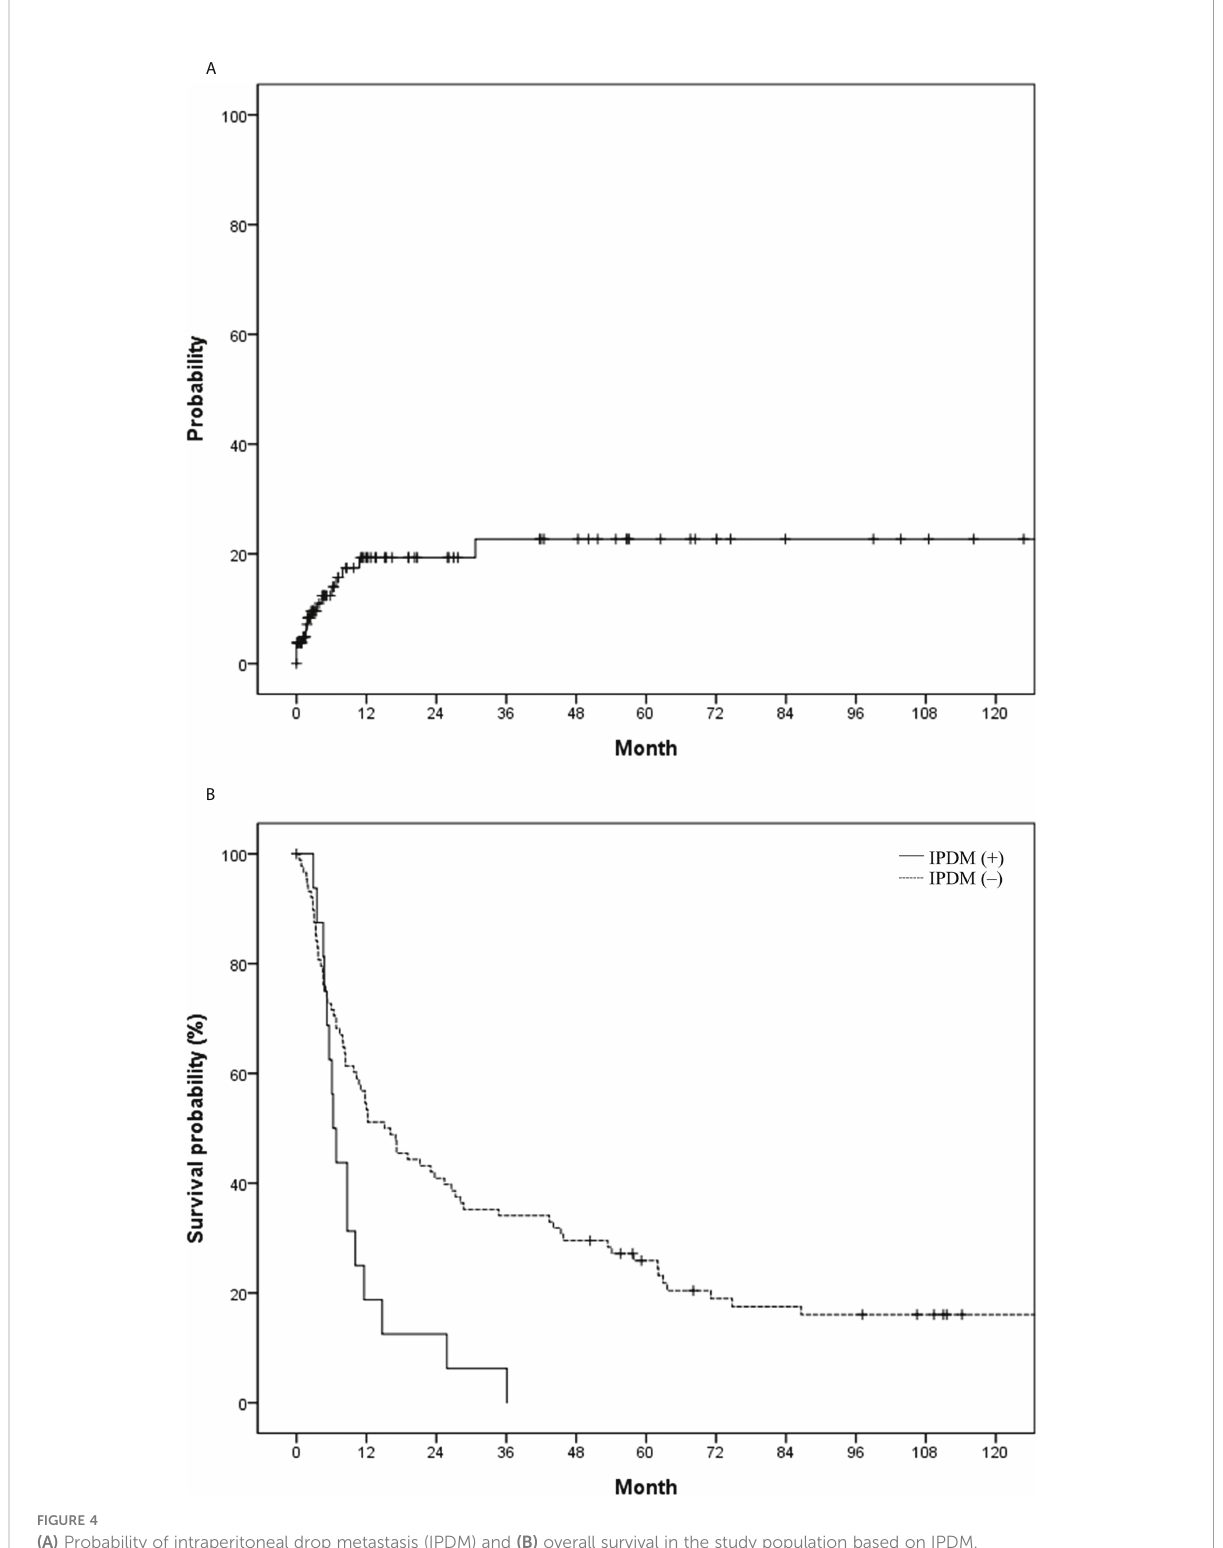
FIGURE 4 (A) Probability of intraperitoneal drop metastasis (IPDM) and (B) overall survival in the study population based on